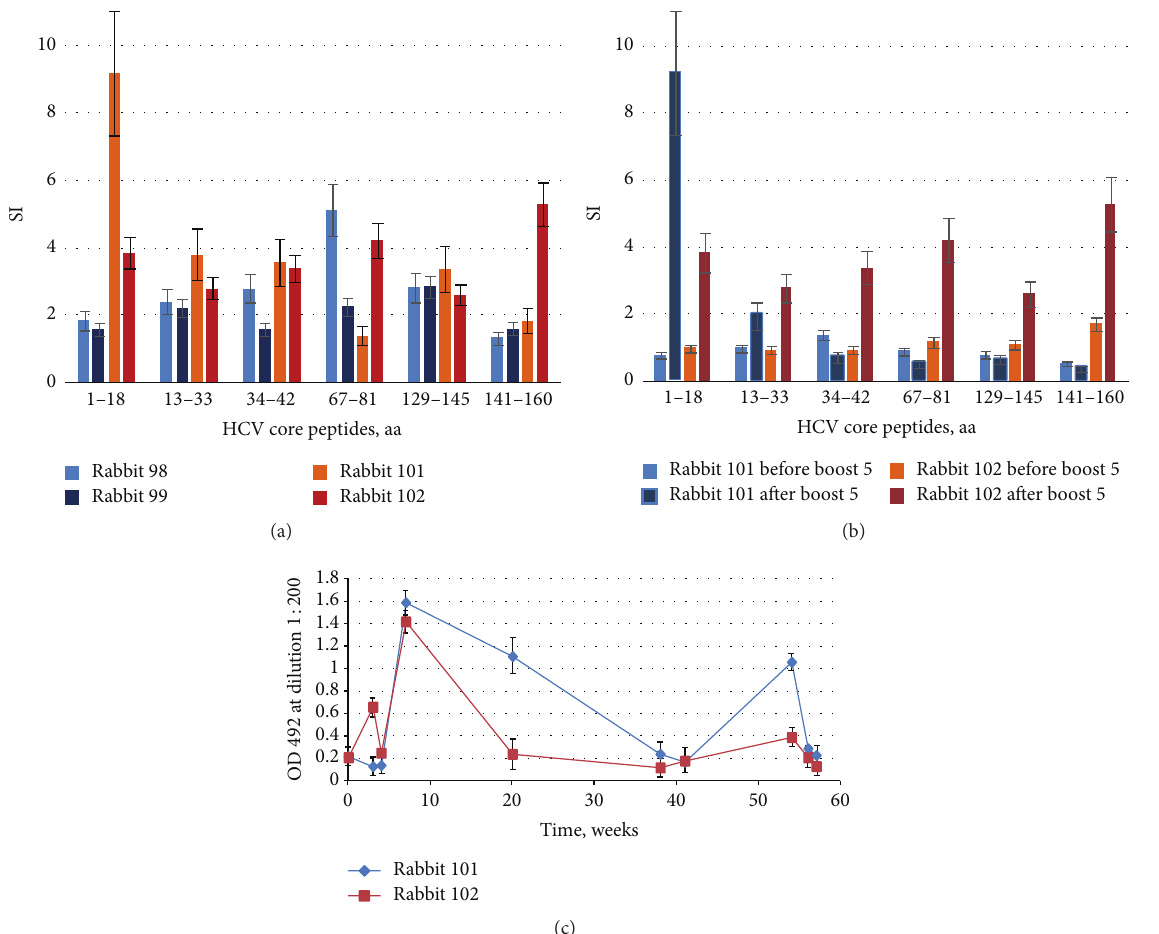
Figure 5: Anti-HCV core immune response induced by single and repeated immunizations with synthetic gene encoding core aa 1– 152 (DNAcore152). Rabbits were regularly bled; PBMCs were isolated and subjected to stimulation with HCV core-derived peptides and recombinant HCV core aa 1–152. Stimulation indexes (SI) observed after double priming (week 4) (a); boosting of T-cell response in rabbits receiving multiple injections of DNAcore152 illustrated by stimulation indexes exhibited by PBMCs of rabbits 101 and 102 before and after boost 5 at weeks 54 and 56, respectively (b); dynamics of antibody response to HCV core aa 1–152 in rabbits receiving repeated injections of DNAcore152 (c). All antigen stimulation tests were performed in triplicate; SI values represent an average with standard deviation. Test results were discarded if radioactivity incorporation values demonstrated by mitogen PHA were below 1000 counts per minute and if stimulation indexes in response to PHA were below 2. HCV core-specific antibodies response represent an average optical density exhibited by sera of each of the rabbits collected at given time points in two ELISA runs with standard deviations. OD of sera of rabbits immunized with empty vector DNA collected at the same time points did not exceed the optical density of 0.3 (data not